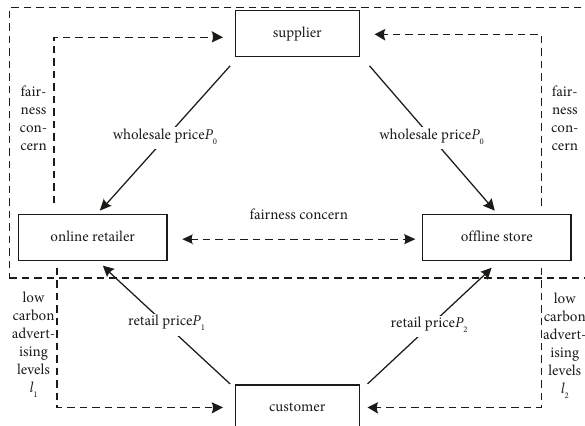
Figure 1: Decision relation of dual-channel supply chain con- sidering fairness